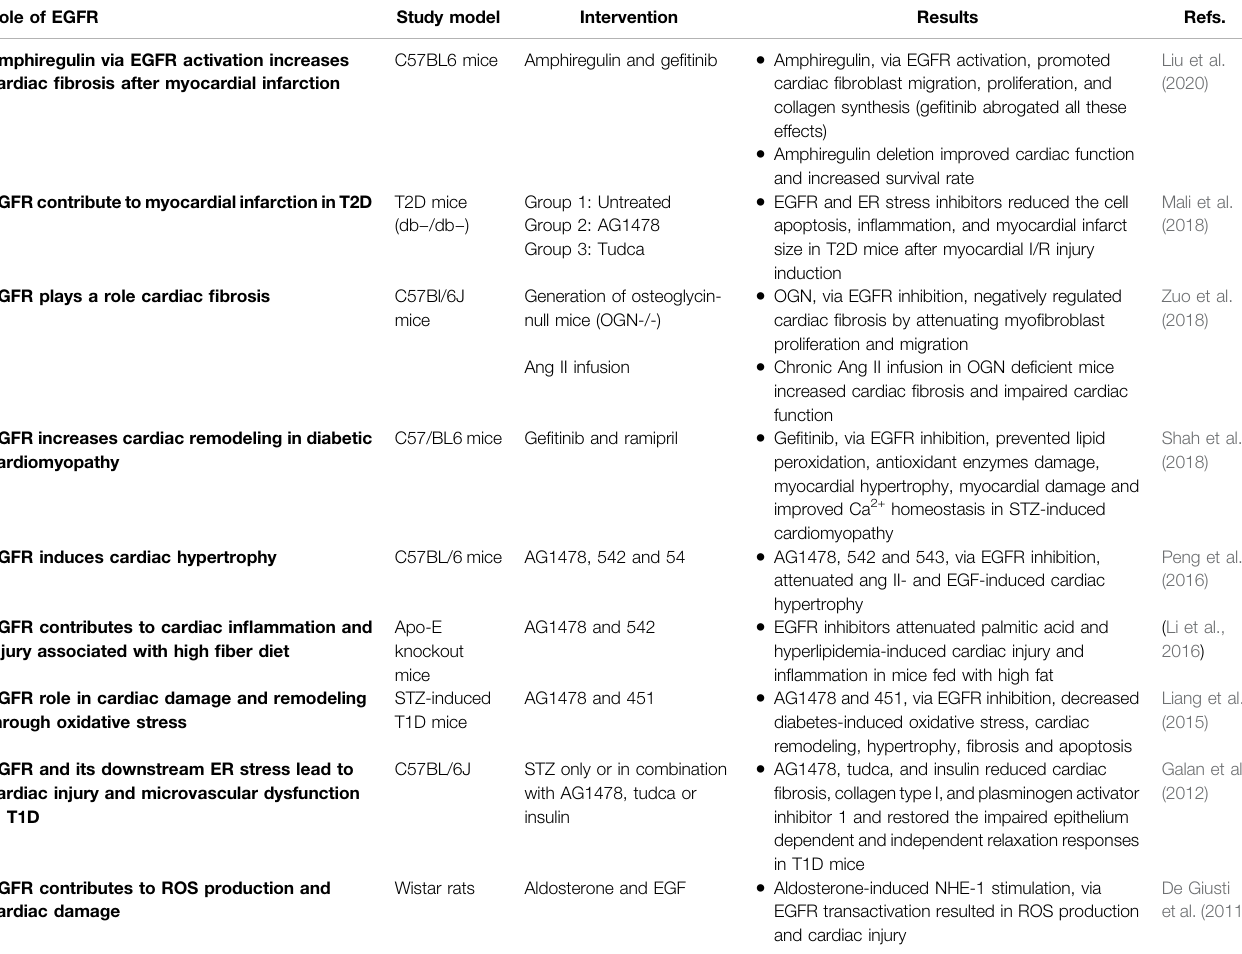
TABLE 2 | A summary of selected in vivo studies highlighting the detrimental role of EGFR/ErbB signaling in the heart. Role of